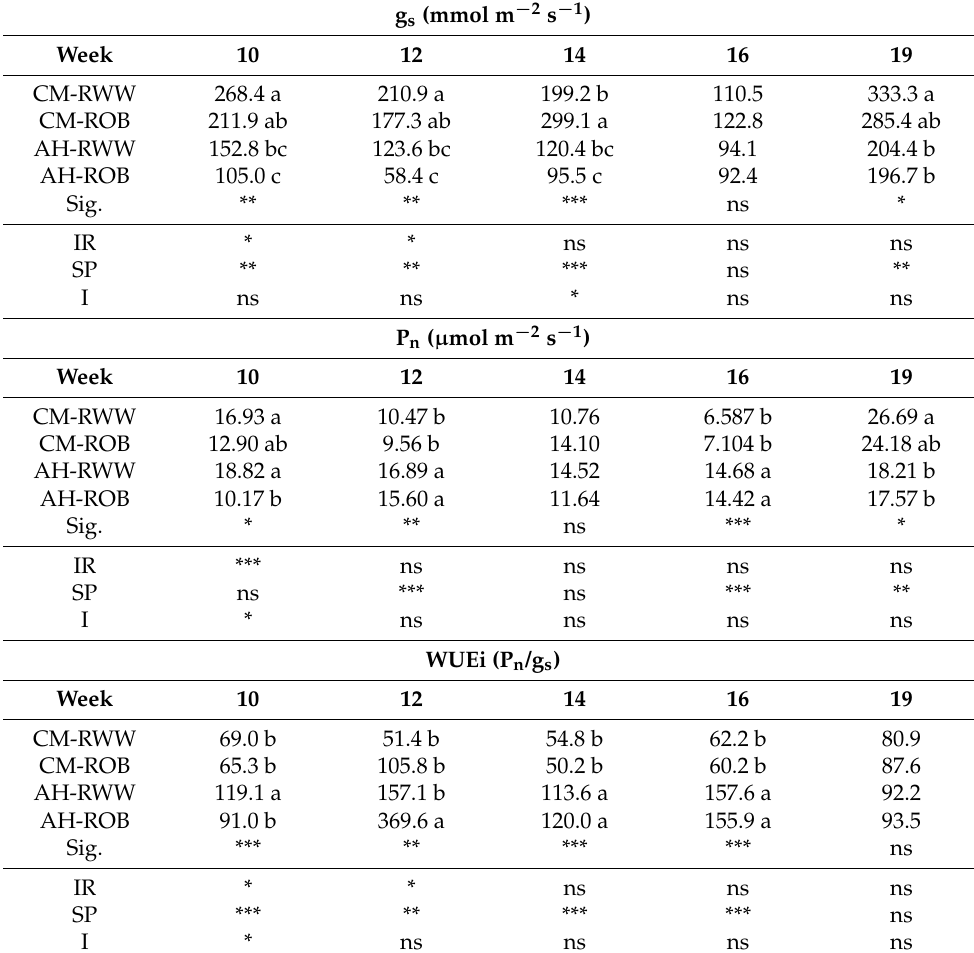
Table 3. Stomatal conductance (g s ), net photosynthetic rate (P n ), and intrinsic water use efficiency (WUE i ) in Crithmum maritimum (CM) and Atriplex halimus (AH), irrigated with reclaimed wastewater (RWW) and reverse osmosis brine (ROB). Results were from one-way and two-way ANOVA tests on these parameters for independent variables (Irrigation, IR, and species, SP) and their interaction (I). Values are means of nine